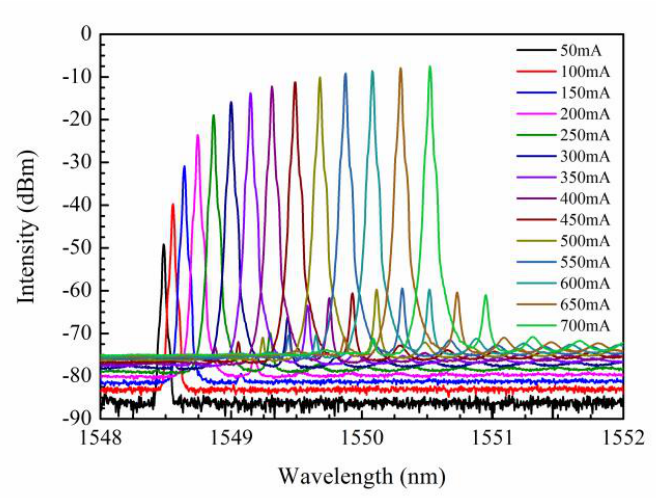
Figure 4. Measured spectrum under different I DFB values where I Tap = 0.5 A.